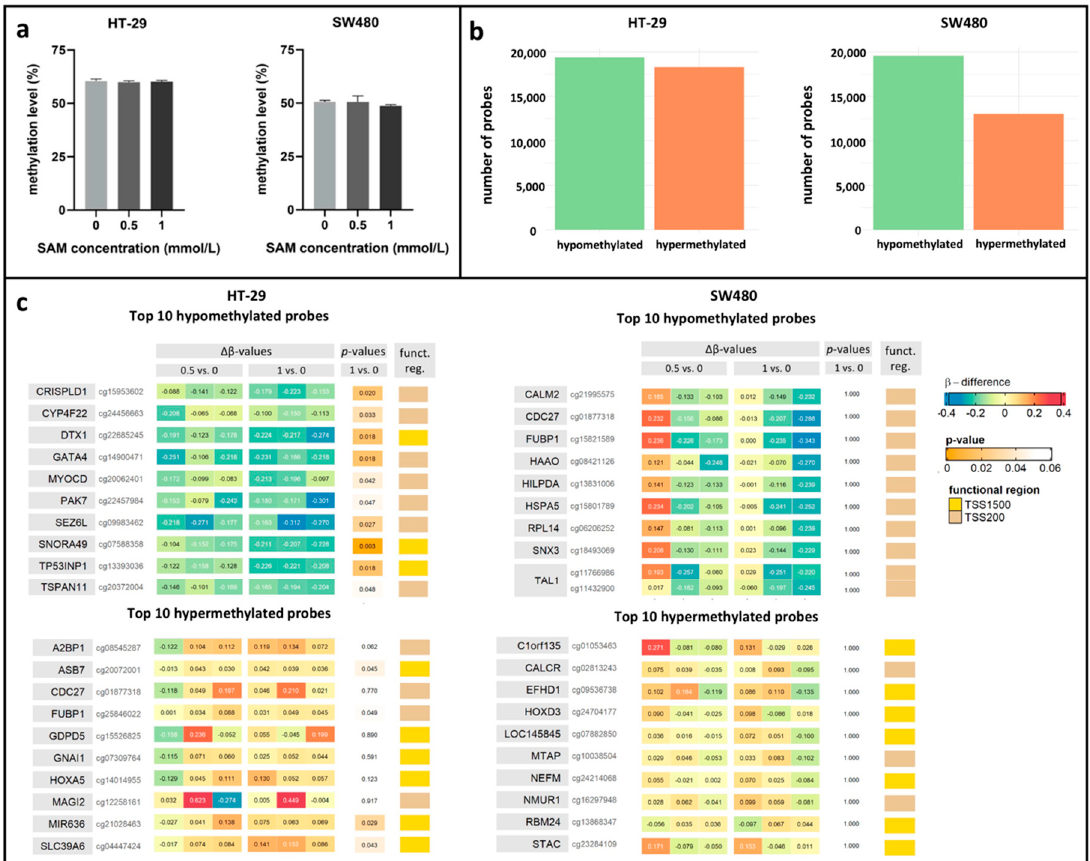
Figure 3. ( a ) Global DNA methylation of control (0 mmol/L) and SAM-treated (0.5 mmol/L; 1 mmol/L) HT-29 (left) and SW480 (right) cells were analyzed by pyrosequencing. DNA methylation status was represented as the average methylation level of three individual CpGs of LINE-1 retrotransposon. ( b ) Promoter-specific methylation of SAM-treated HT-29 (left) and SW480 (right) cells was detected with EPIC BeadChip array. The number of all hypo- and hypermethylated probes located in promoter regions of CpG islands are visualized. ( c ) The top 10 hypo- and hypermethylated probes with the largest absolute mean methylation difference ( Δβ ) between SAM-treated (0.5 mmol/L; 1 mmol/L) and control (0 mmol/L) HT-29 and SW480 cells were analyzed by EPIC BeadChip array. Funct. reg.: functional region.